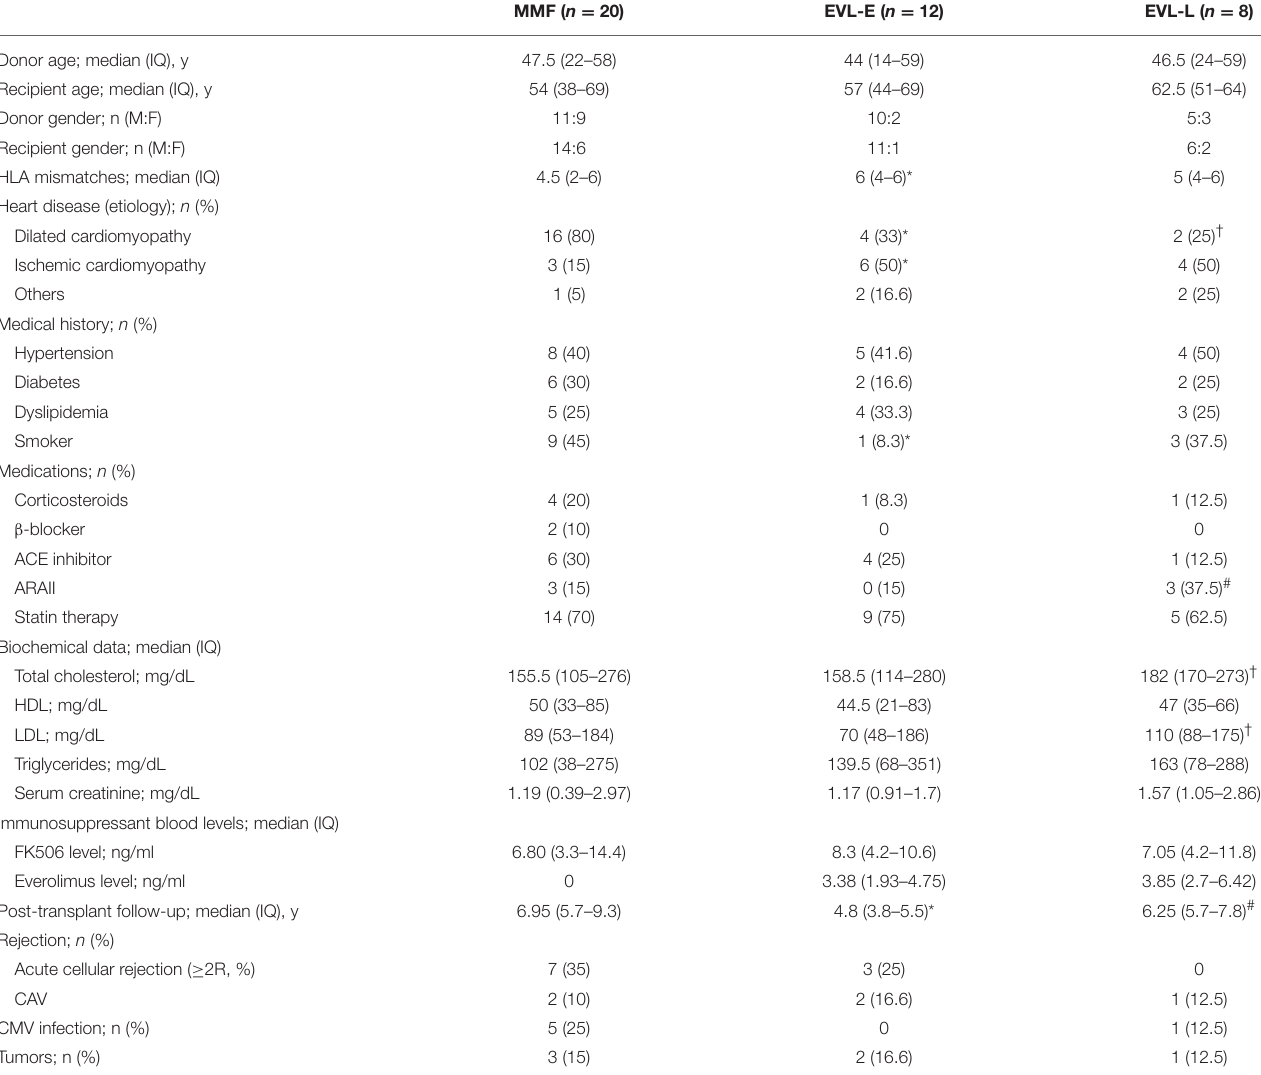
TABLE 1 | Clinical characteristics of HT patients, by treatment